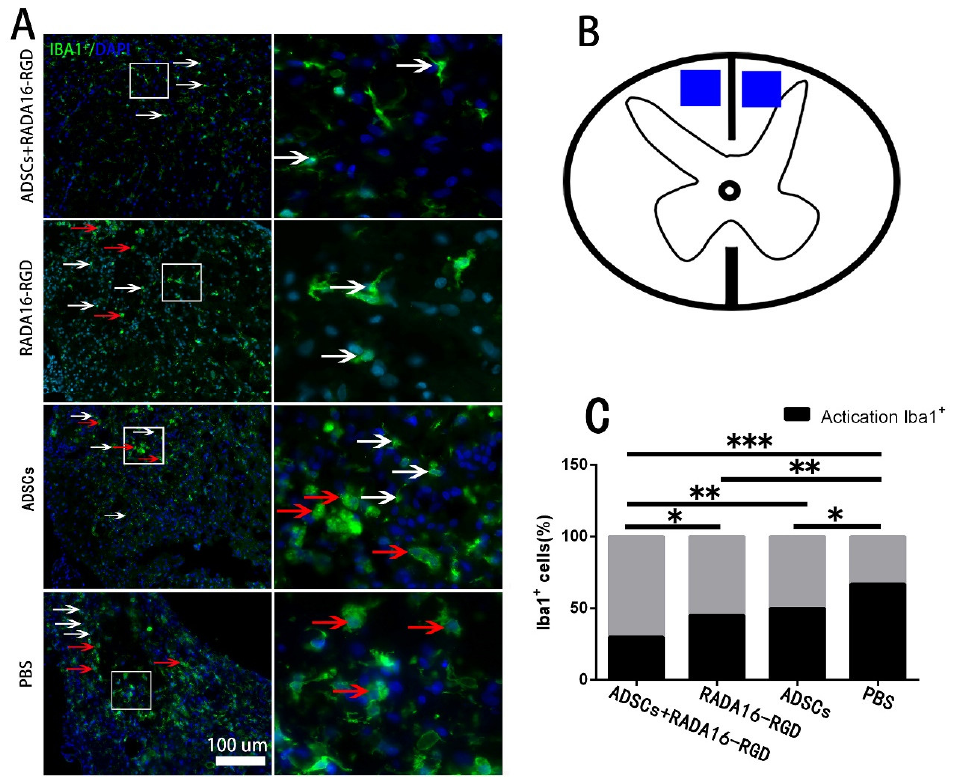
Figure 8. ADSCs+RADA16-RGD inhibited macrophage/microglial activation. ( A ) At 8 weeks of ADSCs+RADA16-RGD transplantation, Iba1 antibody (green) staining at 4 mm cephalic to the injury center was performed. Inactivated Iba1 + cells were smaller and shaped like stars with elongated branches (white arrows), while the activated cells were larger and in a round shape with fewer branches (red arrows). The right image is a high magnification of the corresponding area of the left image. ( B ) The blue area is the area where the cells are counted. ( C ) Statistics of Iba1 + cell activation rate at 4 mm cephalic to the injury center. The activation rate of Iba1 + cells (activated Iba1 + cells/Iba1 + cells) at 4 mm on the cephalic side of the injury center in the ADSCs+RADA16-RGD group was significantly lower than that of the PBS, ADSCs, and RADA16-RGD groups (ADSCs+RADA16-RGD vs. PBS: p < 0.001, ADSCs+RADA16-RGD vs. ADSCs: p < 0.01, ADSCs+RADA16-RGD vs. RADA16- RGD: p < 0.05), while that of the ADSCs and RADA16-RGD groups was significantly lower than that of the PBS groups (RADA16-RGD vs. PBS: p < 0.01, ADSCs vs. PBS: p < 0.05). * p < 0.05, ** p < 0.01, *** p < 0.001. Data are presented as n% ( n = 4 per group). Scale bar = 100 µ m. ADSCs: adipose stem cells; Iba1: ionized calcium-binding adapter molecule 1; DAPI: 4′6-diamidino-2-phenylindole. Iba1 (green): Alexa Fluor 488.